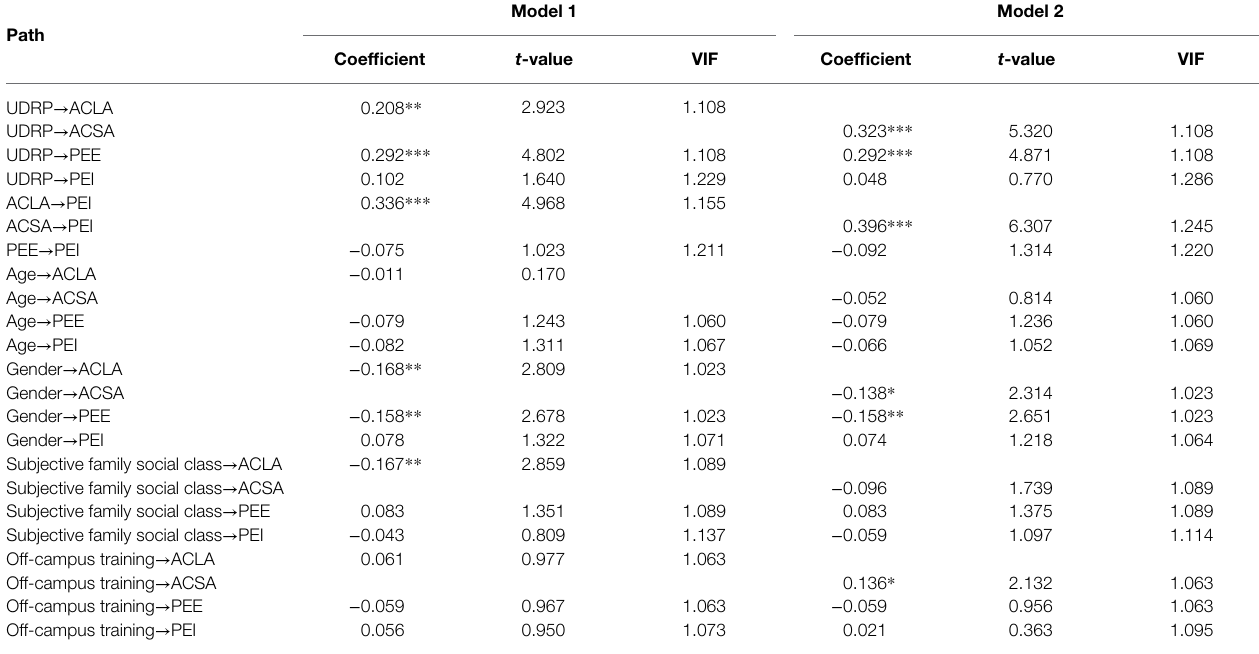
TABLE 4 | PLS path coefficient.